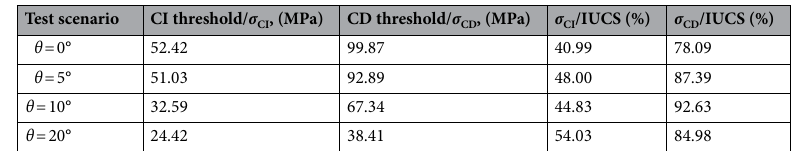
Table 6. Mean value of σ CI , σ CD , σ CI /IUCS and σ CD /IUCS determined by Tables 5 and 6.